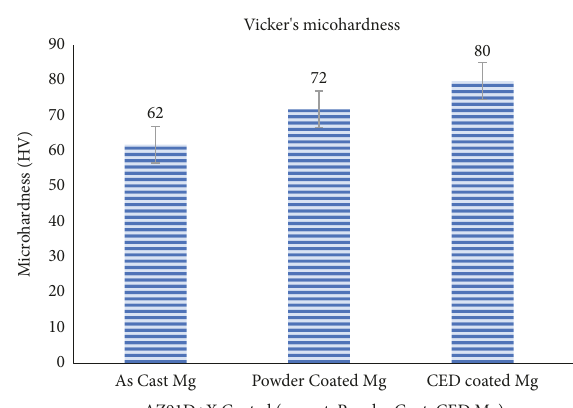
Figure 10: Vickers microhardness